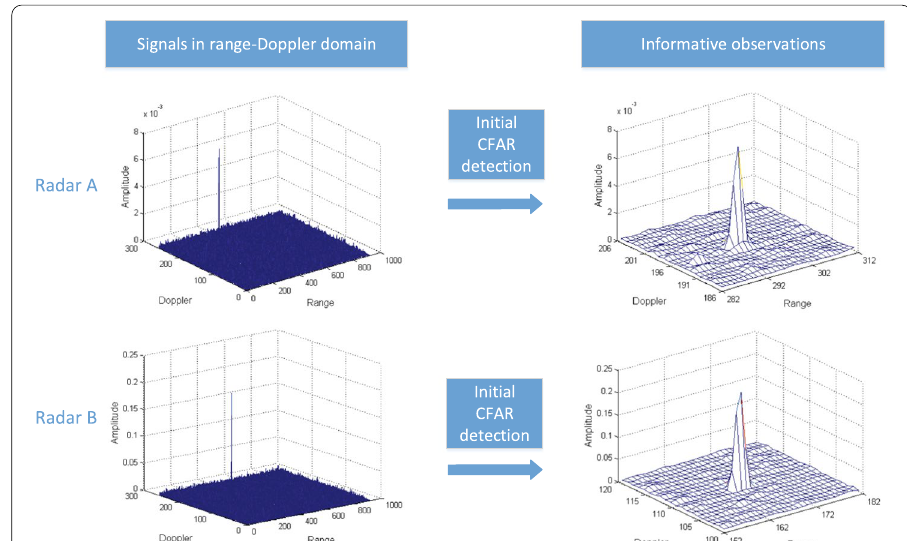
Fig. 6 Data censor for the signals in range-Doppler